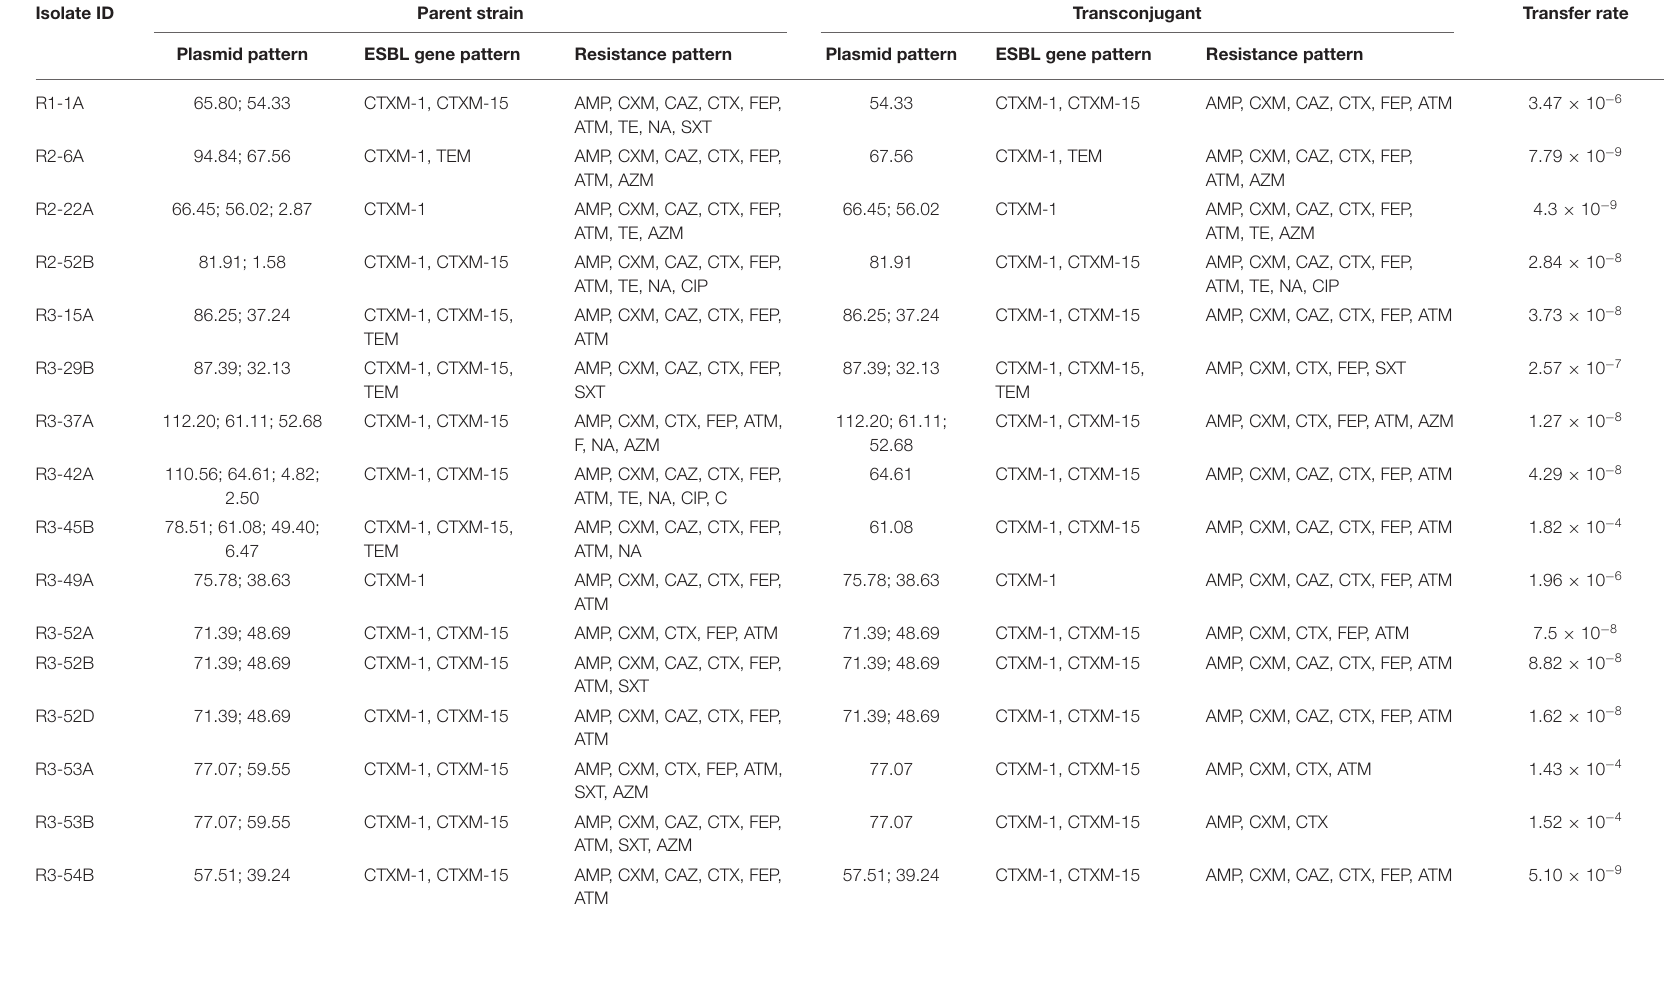
TABLE 3 | Findings of conjugation assays between antibiotic resistant E. coli isolates obtained from faecal sludge samples and the recipient E. coli J53 strain. Isolate